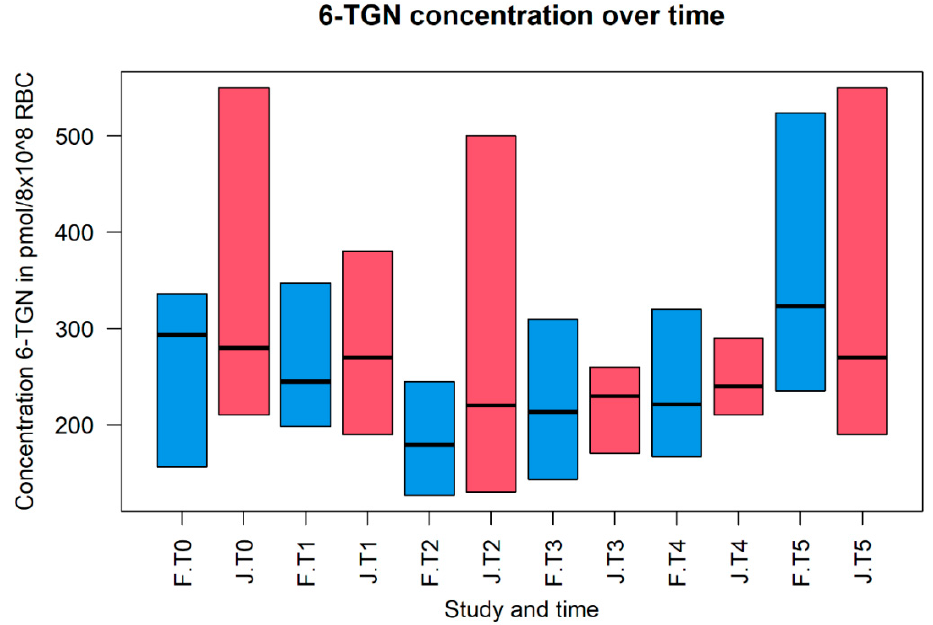
Figure 2. The concentration of 6-thioguanine nucleotides (6-TGN) during the different states of pregnancy. Concentrations of 6-TGN are expressed in pmol × 10 8 Red Blood Cell (RBC) count on the y -axis (median with corresponding 25th and 75th percentile). The different states of pregnancy per study are shown on the x -axis. The different states are expressed as pre-pregnancy (T0), trimesters one until three (T1, T2 and T3), delivery (T4) and postnatal (T5). F, the blue bar, represents the study of Flanagan et al. (2021); and J, the red bar, represents the study of Jharap et al. (2013)